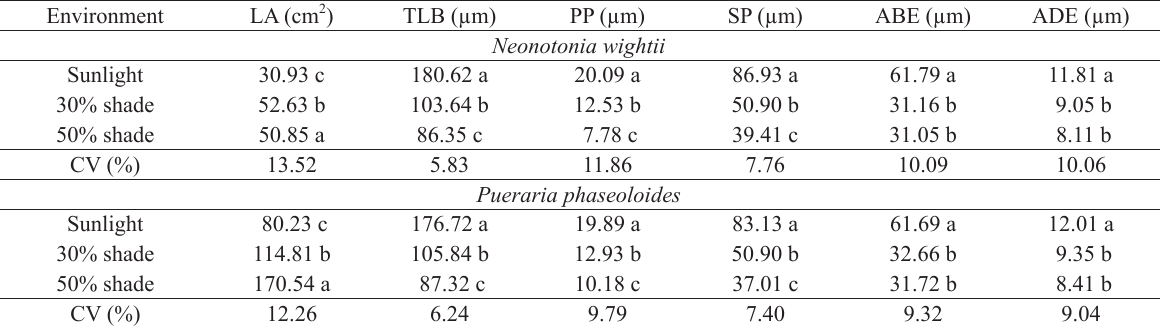
Mean area per leaf (LA) and thicknesses of the leaf blade (TLB), palisade parenchyma (PP), spongy parenchyma (SP), abaxial epidermis (ABE), and adaxial epidermis (ADE) of Neonotonia wightii and Pueraria phaseoloides cultivated under different light intensities.